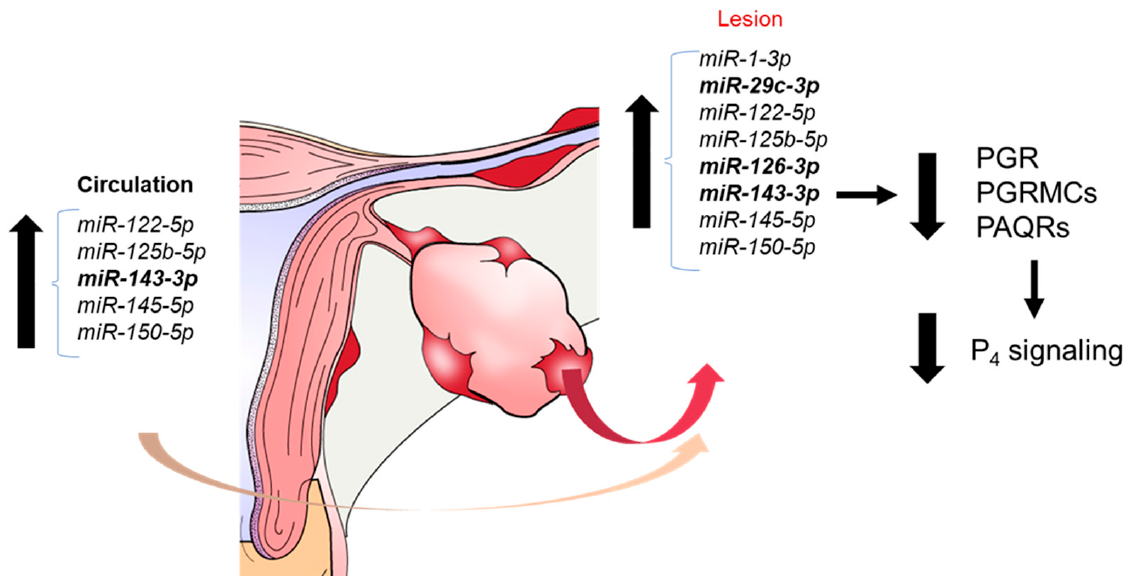
Figure 3. Elevated miRNAs in the circulation and/or lesion of endometriosis patients that may target PGRA/B, PGRMCs or PAQRs.